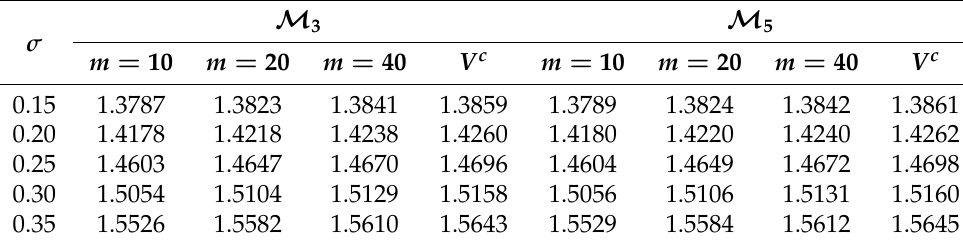
Table A3. Valuation results w.r.t. σ , g = 2.50%, α = 90%, and n =